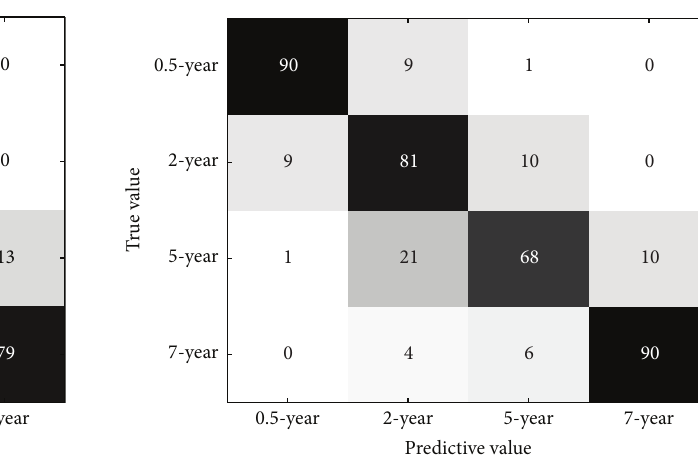
Figure 9: Optimized DFNN confusion matrix for training samples.